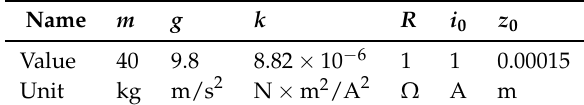
Table 2. Parameter values of the electromagnetic thrust bearing